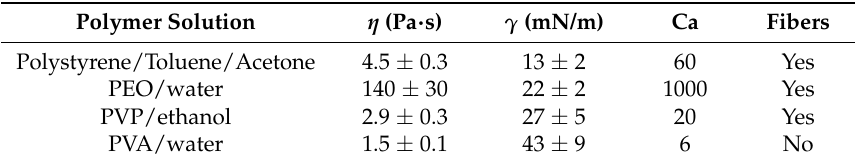
Table 1. Polymer solution properties and capillary numbers. PEO: polyethylene oxide; PVP: polyvinylpyrrolidone; PVA: polyvinyl